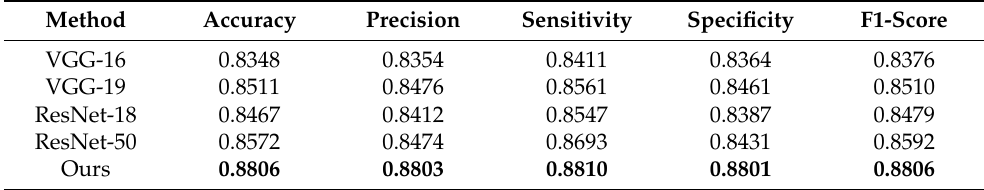
Table 2. Classification results of CESM images using different deep learning methods. The bold values represent the best value.